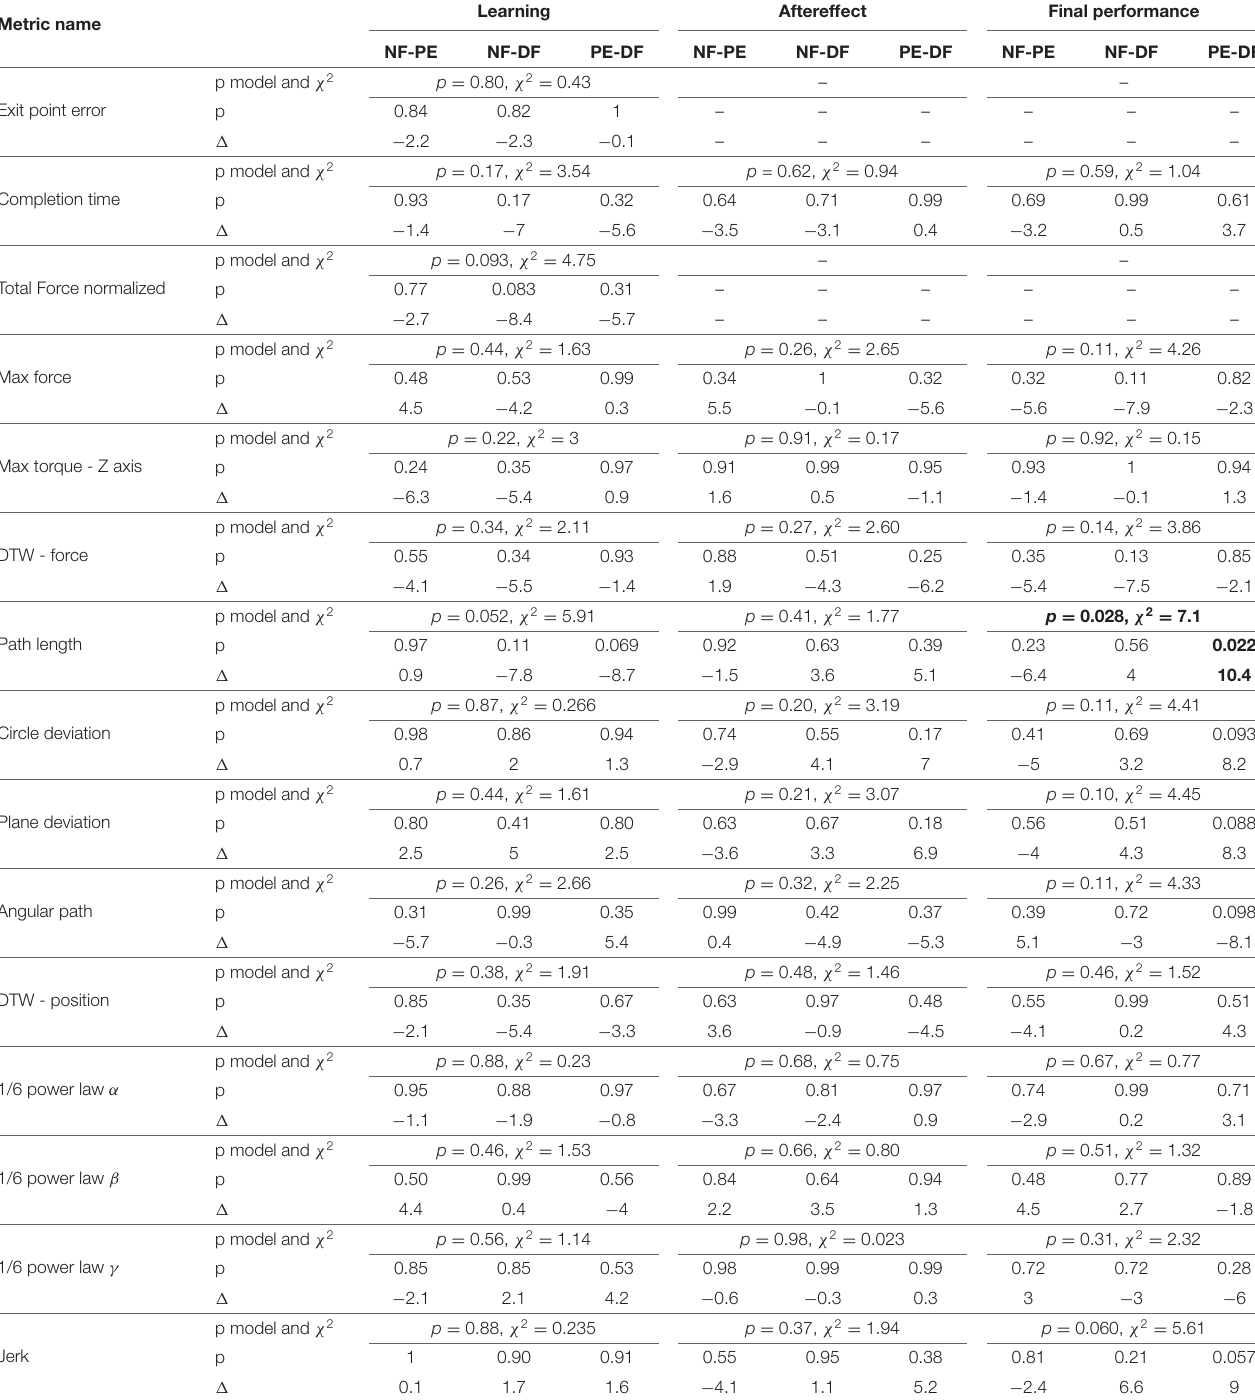
TABLE 2 | Statistical analysis—Kruskal-Wallis